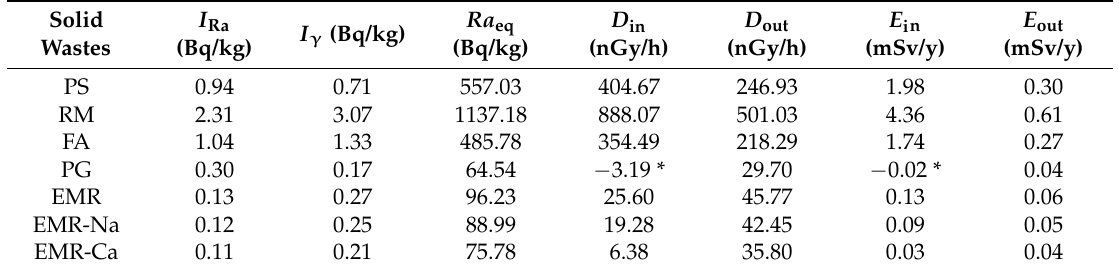
Table 6. The I Ra , I γ , Ra eq , D in , D out , E in , and E out for industrial solid wastes.